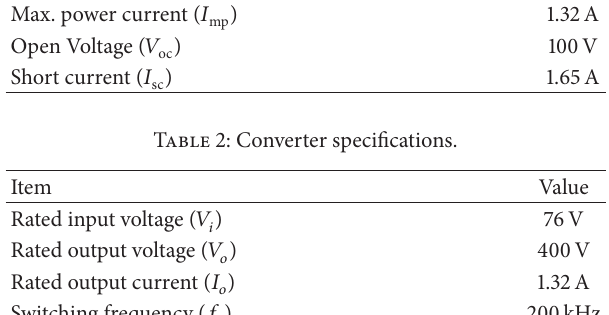
Figure 8: Efficiency versus load current.